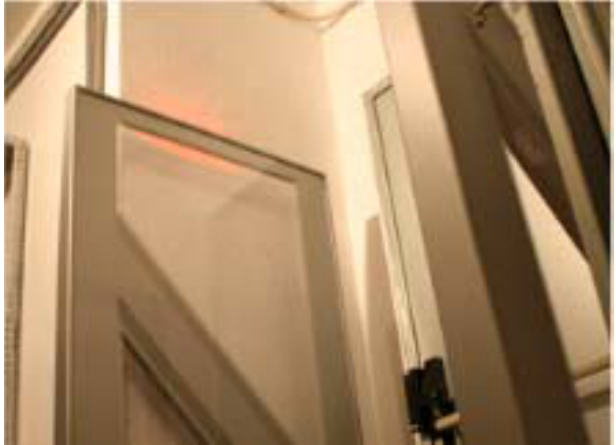
Figure 4. Gate Subsystem deployed in a